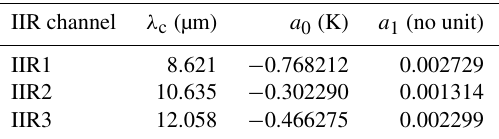
Table 2. Coefficients in Eq. (3) to convert IIR Level 1b radiances